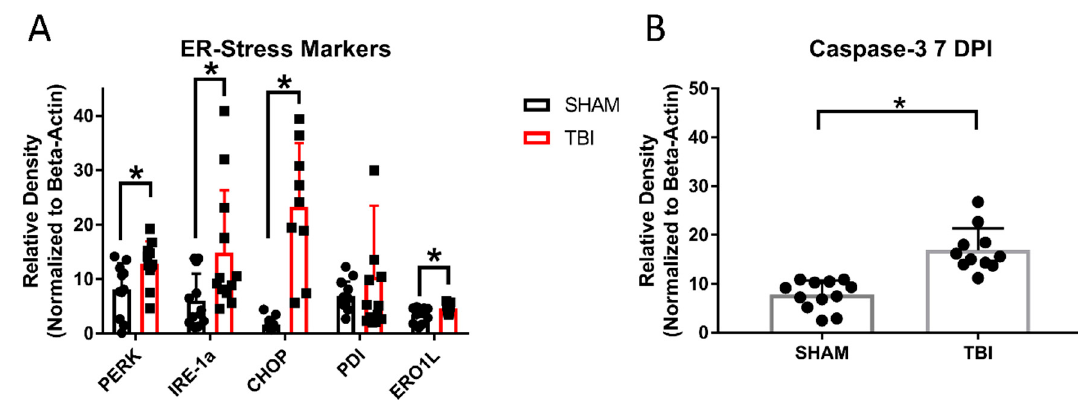
Figure 10. Markers of apoptosis and endoplasmic reticulum stress in the retinas of TBI/iTON mice 7 DPI. ( A ) Shows markes implicated in ER stress, ( B ) shows elevated Caspase-3 (an apoptotic marker). Protein measurements were normalized to beta-actin. * p < 0.05.